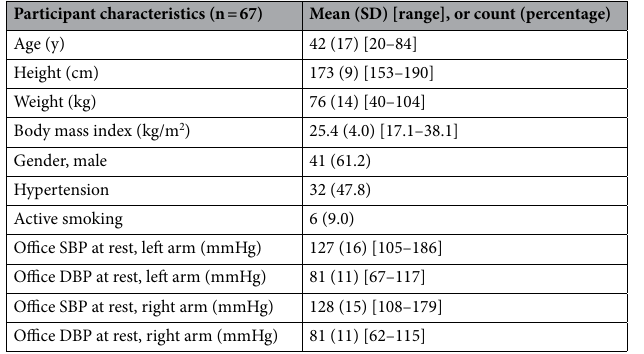
Table 1. Biometric characteristics of the 67 participants included in the analysis. The data are given as “mean (SD) [range]” or “count (percentage)” over the cohort. SD standard deviation, SBP , DBP systolic, diastolic blood pressure.